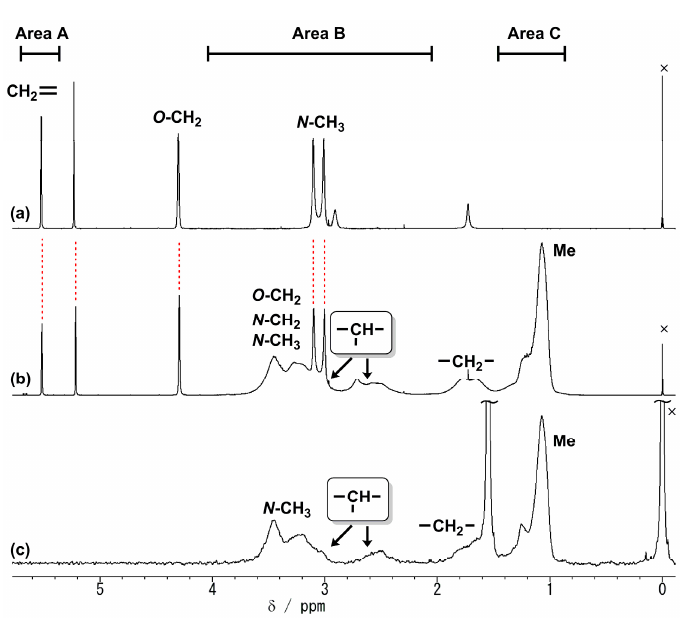
Figure 2. 1 H NMR spectra of ( a ) DM α HAA, ( b ) poly(DM α HAA- co -DEAA) obtained from Run 5, and ( c ) poly(DEAA) (400 MHz, CDCl 3 , 25 °C). × : Tetramethylsilane.